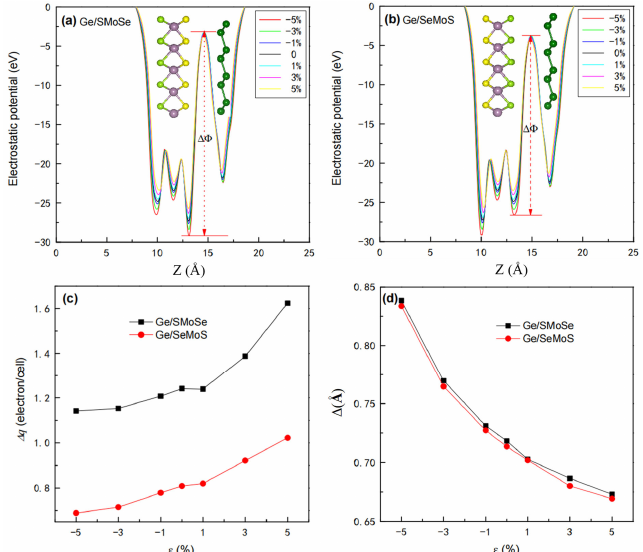
Figure 8. Electrostatic potentials of ( a ) Ge/SMoSe and ( b ) Ge/SeMoS heterostructures under different strains. Corresponding charge transfers q from germanene to the MoSSe layer, buckling of the germanene layer , as functions of strain are given in ( c , d ), respectively.